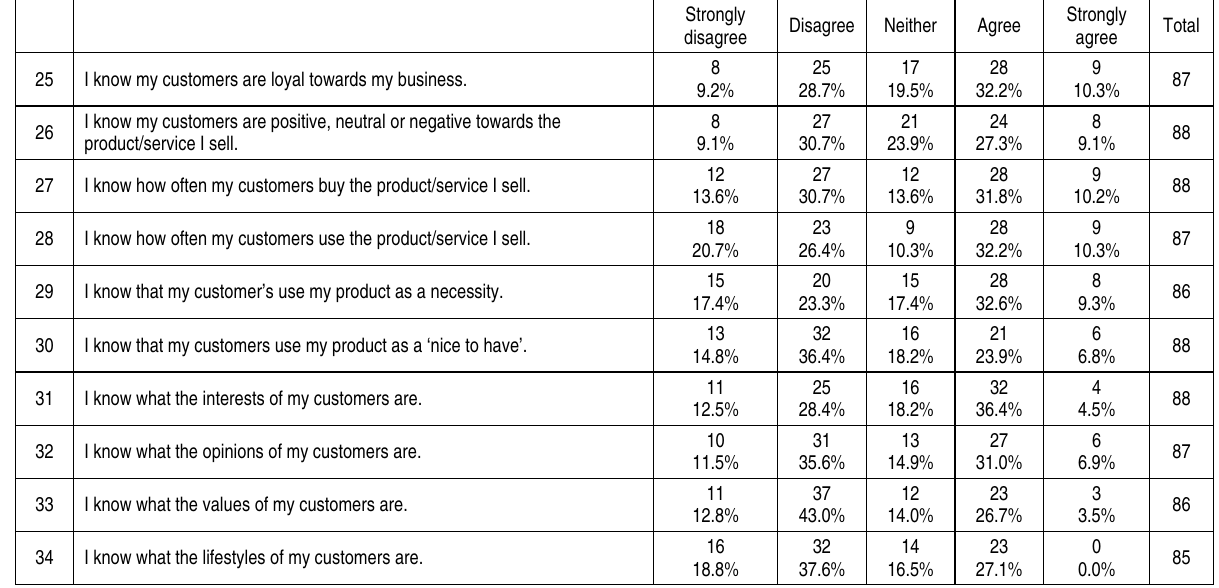
Table 1 (cont.). Distribution of responses on customer knowledge statements